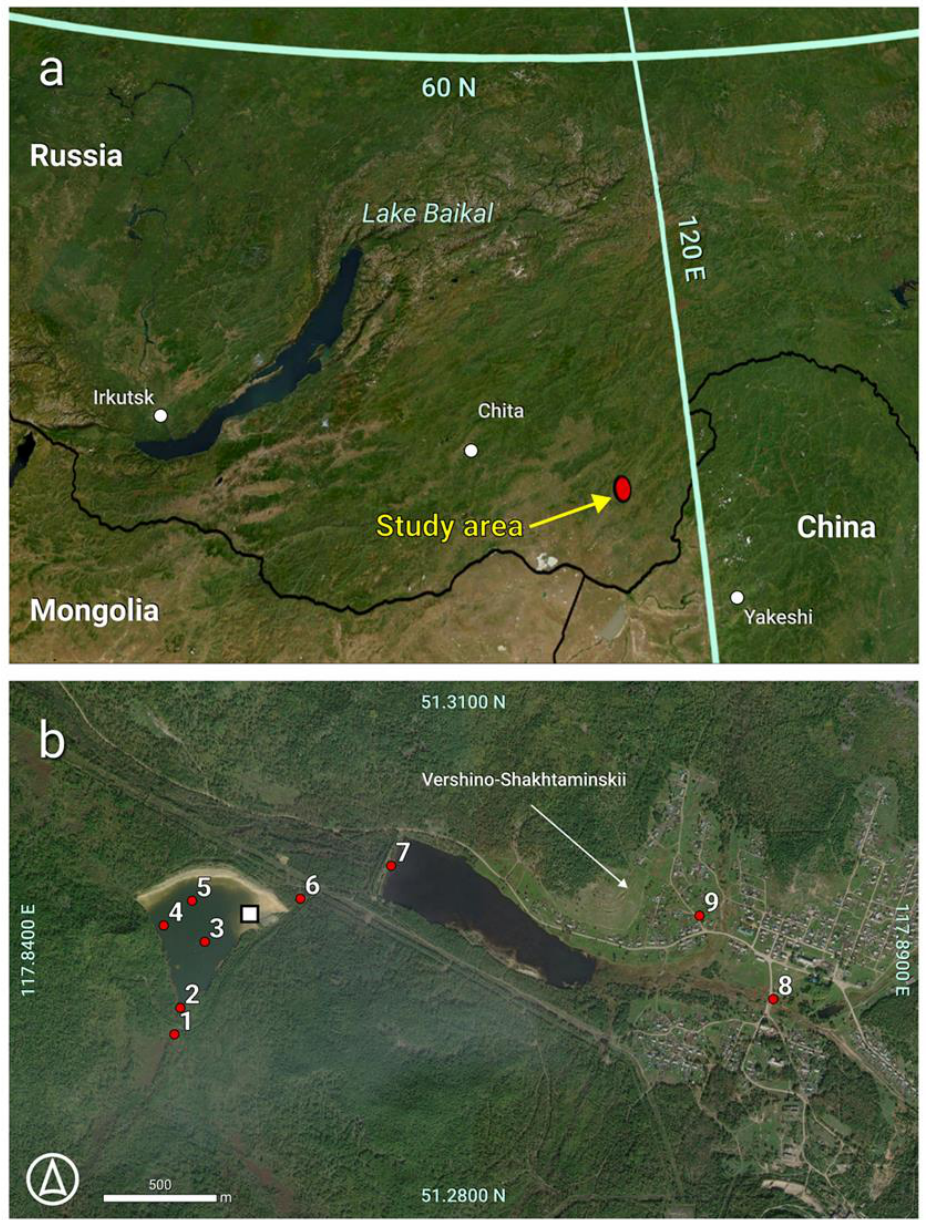
Figure 1. Study area: Vershino-Shahtaminskii in the Transbaikal region, Russia ( a ), tailings of the Shahtama molybdenium ores processing ( b ) (points 1–6), storage reservoir (7), Shahtama River (8), drinking water well (9), pit (white square).